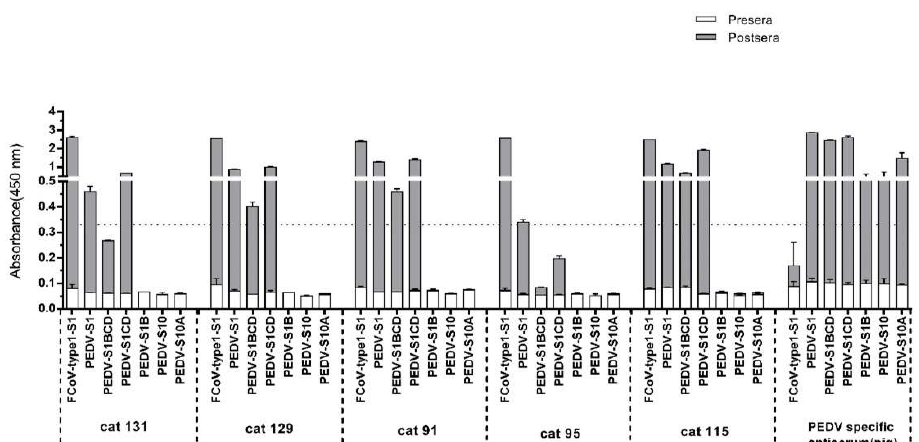
Figure 4. Reactivity of feline sera pre- and post FCoV type 1 infection to porcine epidemic diarrhea virus (PEDV) S1 domains determined by ELISA. Equal molar amount of purified S1 proteins and PEDV S1 subdomains were coated onto 96-well plates and antibody binding was tested by ELISA. Serum samples tested are indicated at the bottom of each panel. Moreover, absorbance at 450 nm and antigens are shown on the y- and x-axis, respectively. OD450 values of feline sera pre- and post FCoV infection were superimposed to one bar. Cat 91–131: sera from SPF cats pre- and post-experimental infection with FCoV type 1; PEDV specific antiserum: sera collected from a pig pre- and post-experimental inoculation with PEDV-S1. The dashed line shows the positive cut-off level. The graphs represent the means from three independent experiments. Error bars indicate standard deviations.